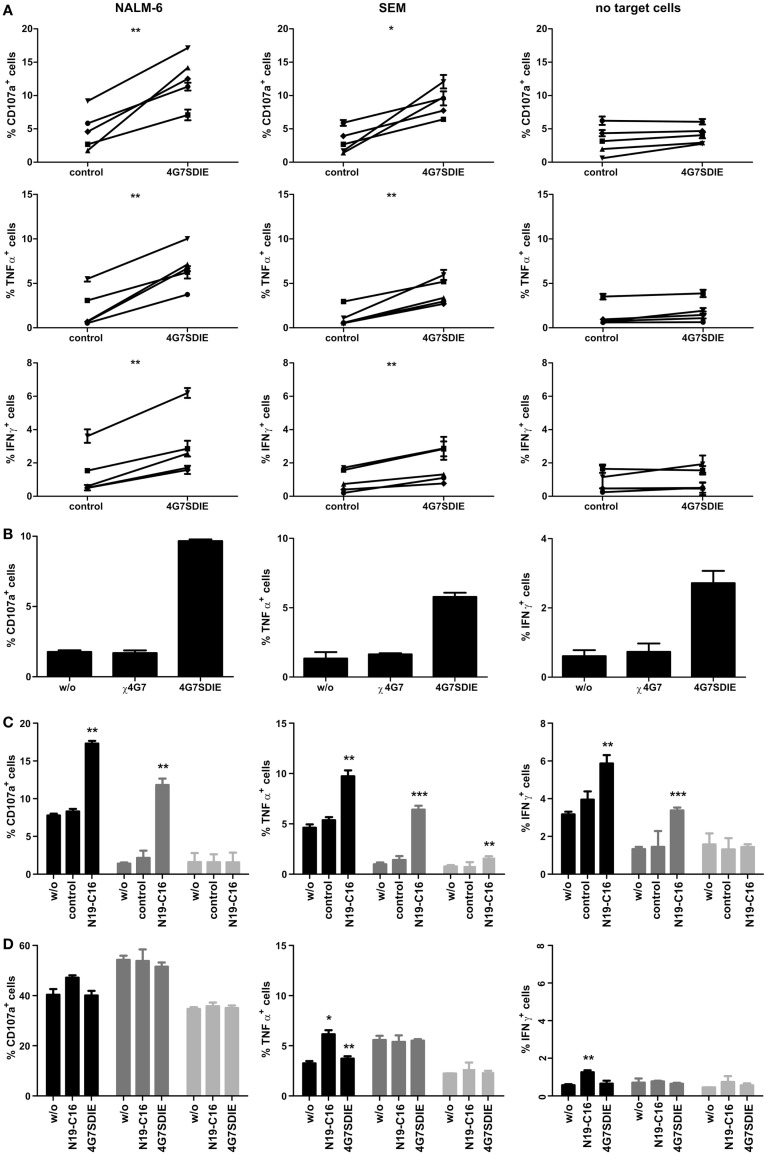
Indirect assessment of primary and expanded γδ T cell-mediated AIC and ADCC in CD107a-degranulation assays and intracellular cytokine stainings (ICS). PBMC (A–C) or expanded, isolated, and recovered γδ T cells (D) were incubated with equal cell numbers of target cell lines NALM-6 or SEM and antibodies for 16 h. γδ T cell degranulation (CD107a) and cytokine production (TNFα and IFNγ) were detected on viable, single CD45+CD3+TCRγδ+ lymphocytes by extracellular and intracellular staining and flow cytometric analysis. (A) PBMC were incubated with or without target cell lines NALM-6 or SEM and 1 μg/ml control antibody or 1 μg/ml 4G7SDIE. Five different donors of 5 independent experiments are shown. (B) PBMC were incubated with target cell line NALM-6 and without antibody, 1 μg/ml χ4G7 or 1 μg/ml 4G7SDIE. One representative experiment, of three independent experiments performed, is shown. (C) PBMC were incubated with or without (light gray bars) target cell lines NALM-6 (black bars) or SEM (gray bars) and without, 1 μg/ml control antibody or 1 μg/ml N19-C16. Experiments were performed in triplicates. (D) Expanded, isolated, and recovered γδ T cells were incubated with or without (light gray bars) target cell lines NALM-6 (black bars) or SEM (gray bars) and without, 1 μg/ml N19-C16 or 1 μg/ml 4G7SDIE. Experiments were performed in triplicates. Error bars represent the standard deviation (SD).